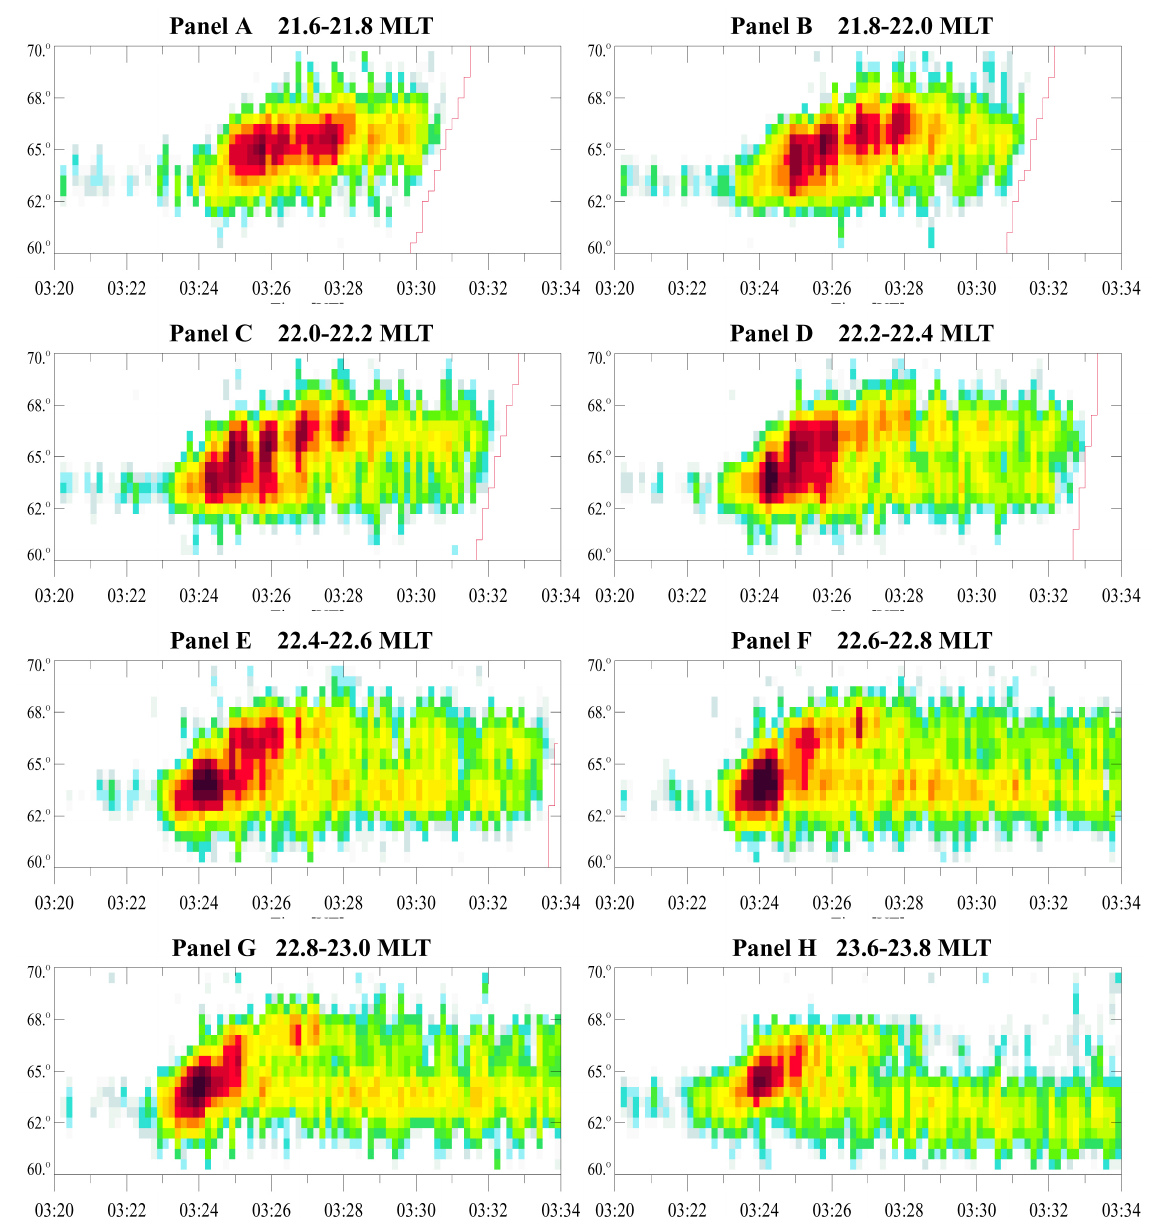
Fig. 6. Keograms for a selection of MLT sectors produced from 2.40–8.82keV photon measurements by PIXIE. The colour scale is the same as in Fig. 3 and the red line give the border of